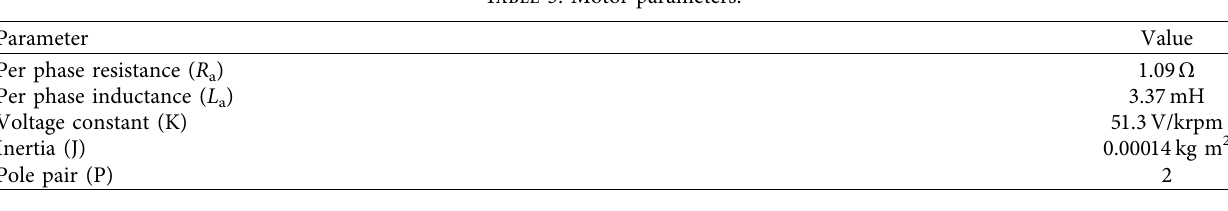
Table 5: Motor parameters.